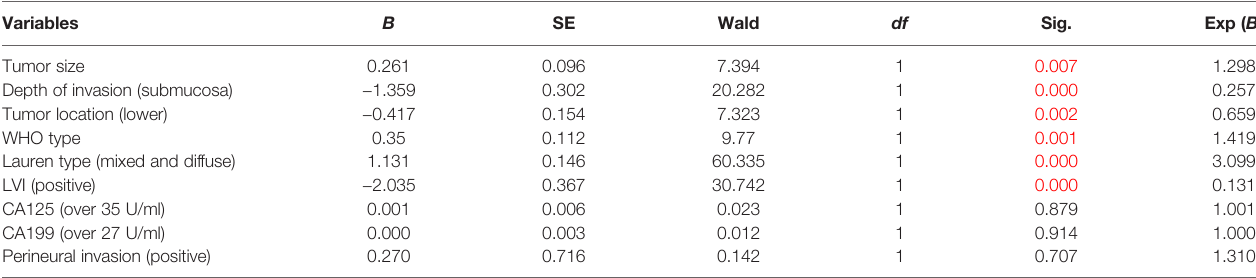
TABLE 4 | Multivariate analysis for LNM in male training set with EGC. Variables B